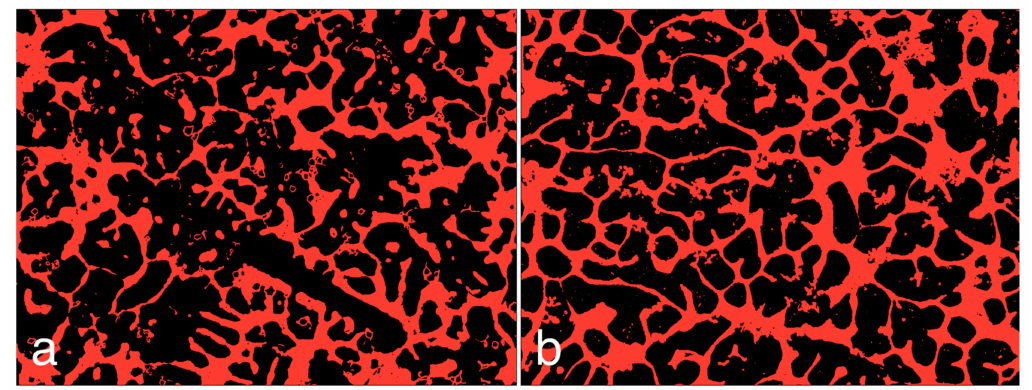
Figure 8. Micrograph highlighting globules (black area) and “frozen” liquid (red area) for B319+Fe alloy after heat treatments using two extreme combinations of temperature and soak time: 575 ◦ C-0 s ( a ) and 595 ◦ C-90 s ( b